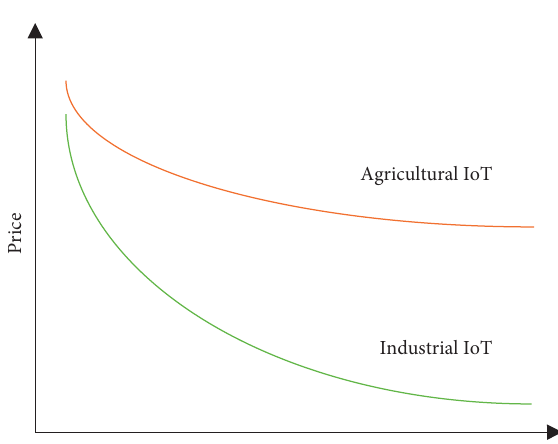
Figure 12: The evolution diagram of the